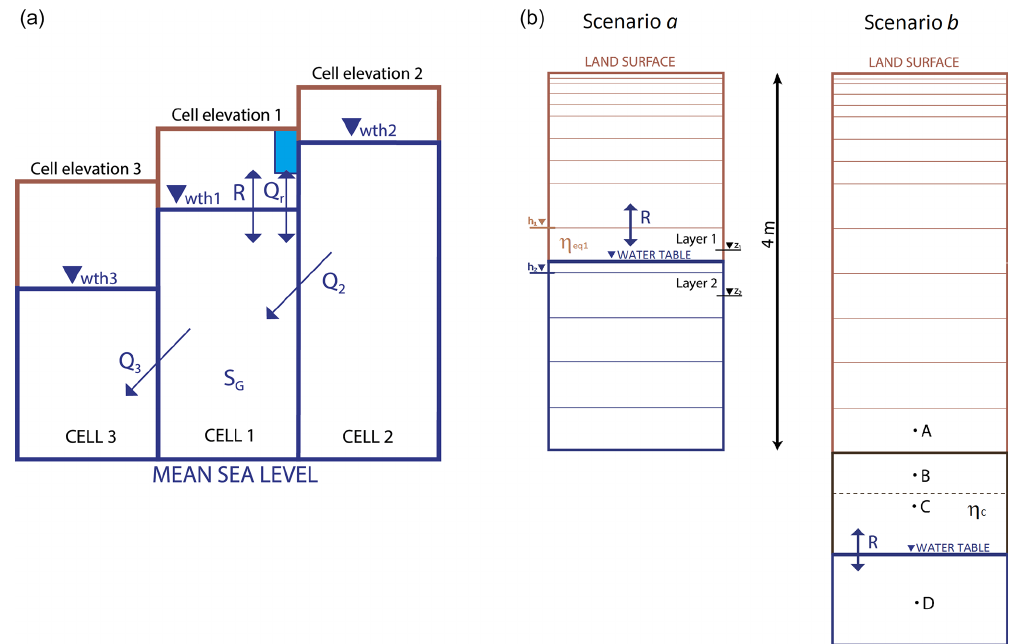
Figure 1. (a) LEAFHYDRO groundwater balance in a model cell (cell 1). (b) LEAFHYDRO double scenario to calculate the water flux through the water table ( R